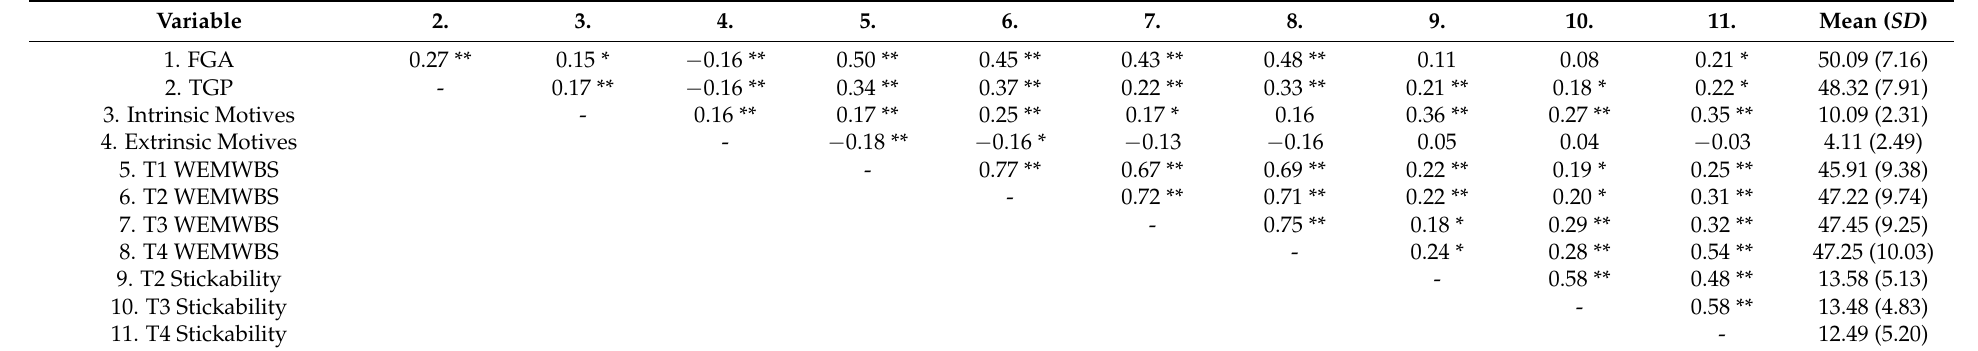
Table 1. Descriptive Statistics and Pearson correlations between main study